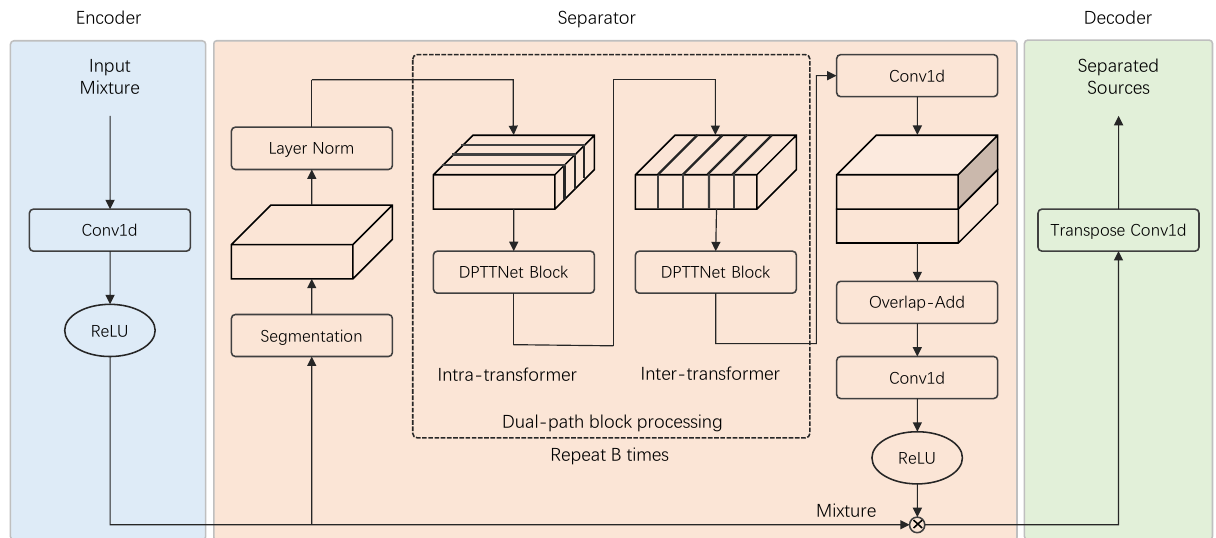
Figure 4. Framework of bird sound separation with dual-path tiny transformer